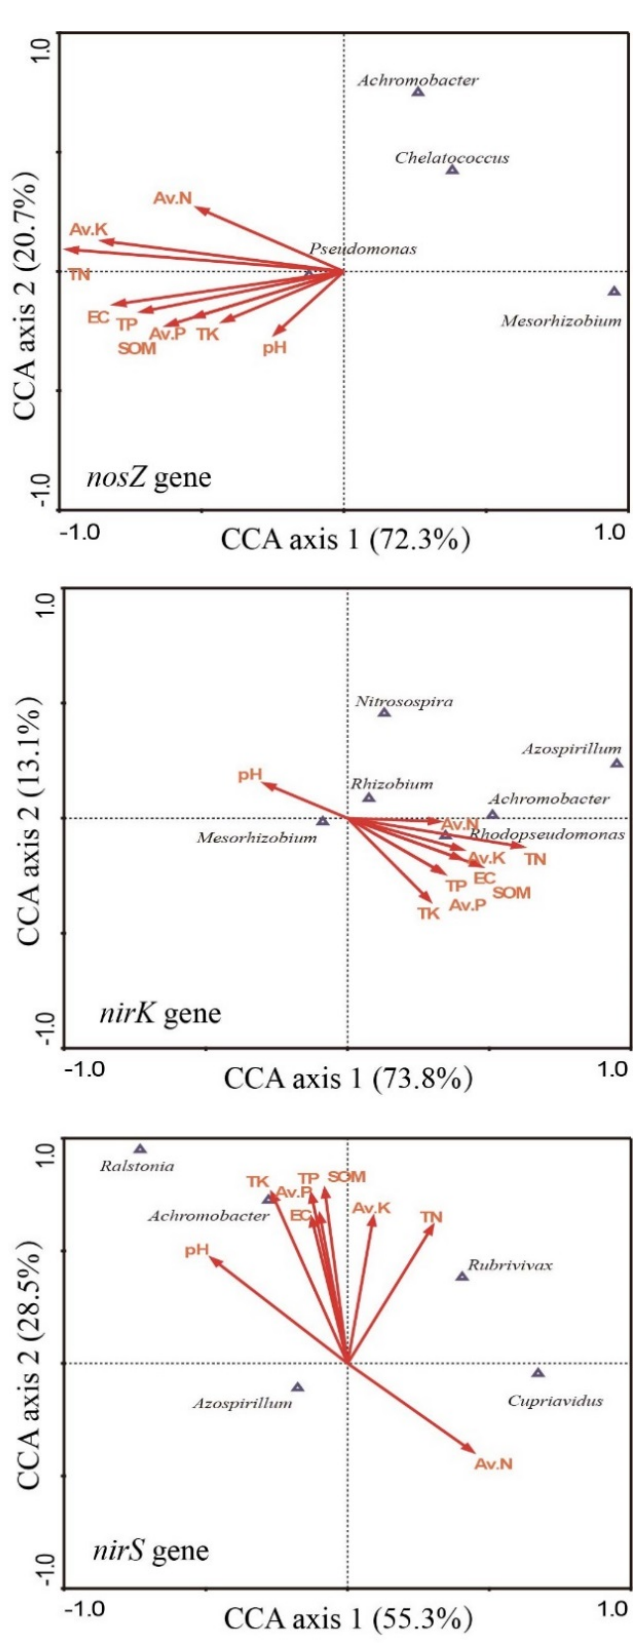
Figure 6. Canonical correspondence analysis (CCA) of dominant genera of nosZ , nirK , and nirS communities and soil properties. SOM: soil organic matter; TP: total P; Av. P: available P; TN: Total N; Av. N: available N; TK: total K; Av. K: available K; EC: electrical conductivity.